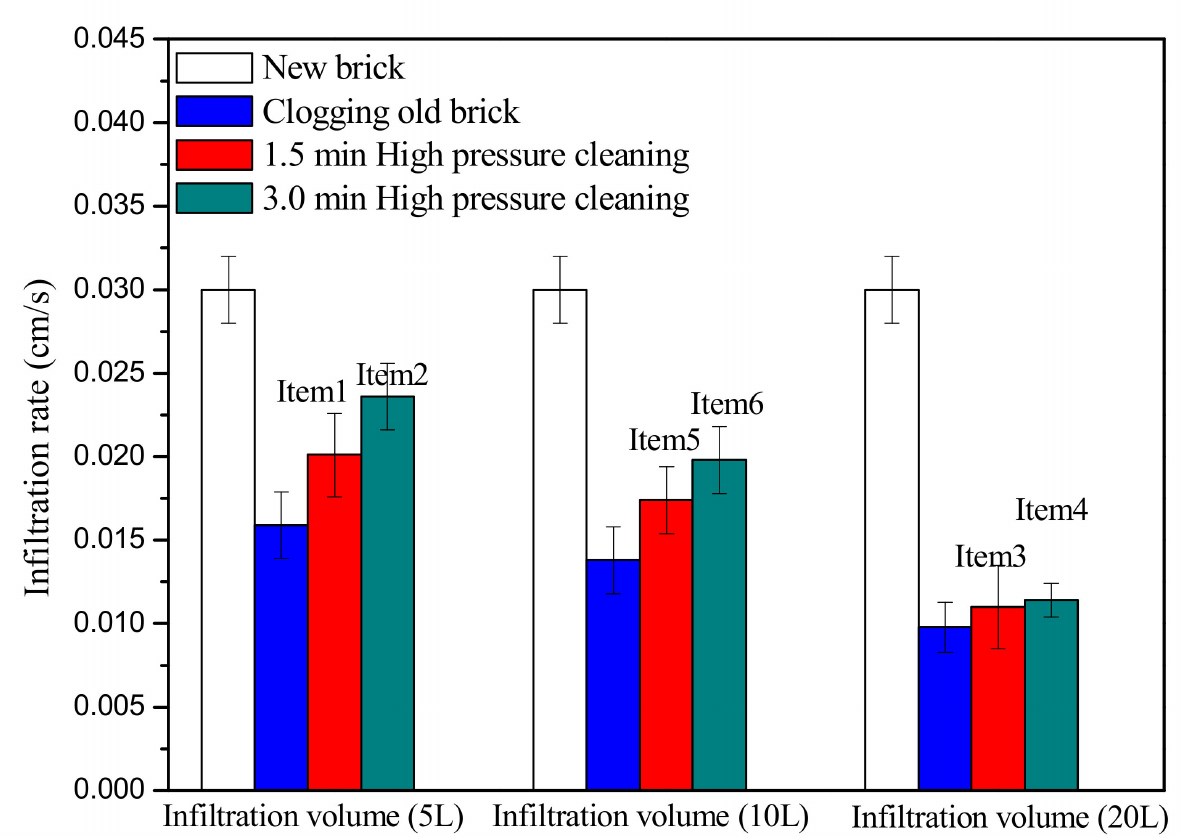
Figure 7. Recovery effect of pressure washing for different cleaning